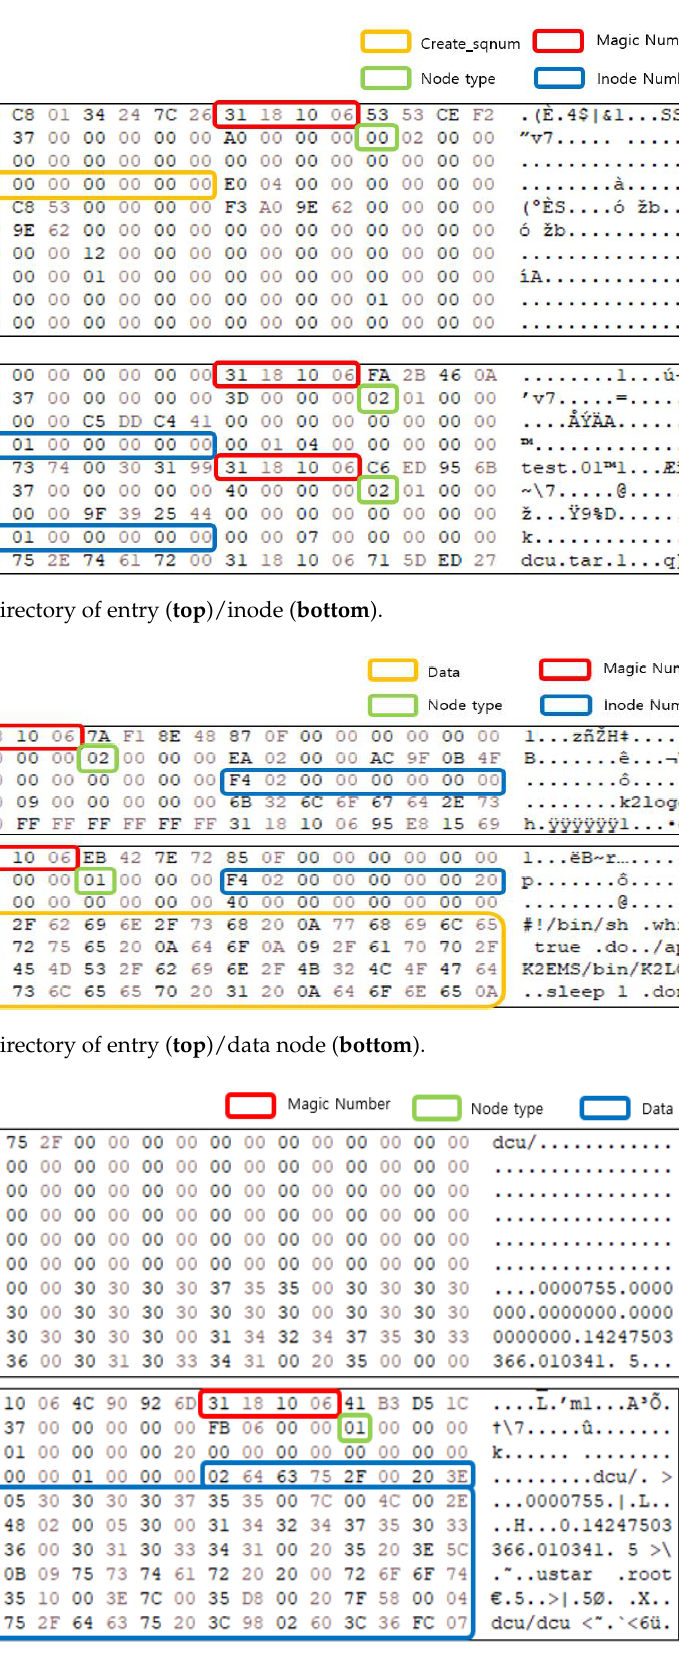
Figure 22. Actual file data in dcu.tar file(top)/data node which is dcu.tar file is stored